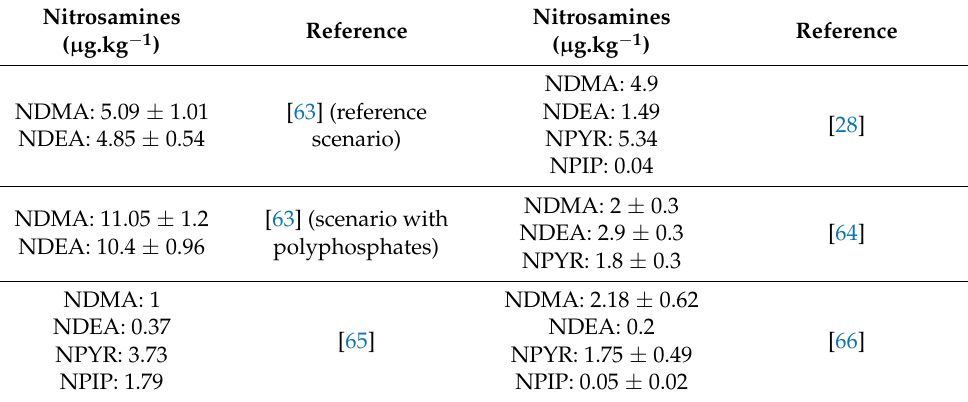
Table 1. The concentration of nitrosamines (N-nitrosodimethylamine (NDMA), N-nitrosodiethy- lamine (NDEA), N-nitrosopyrrolidine (NPYR), and N-nitrosopiperidine (NPIP)) in cooked hams used to estimate the